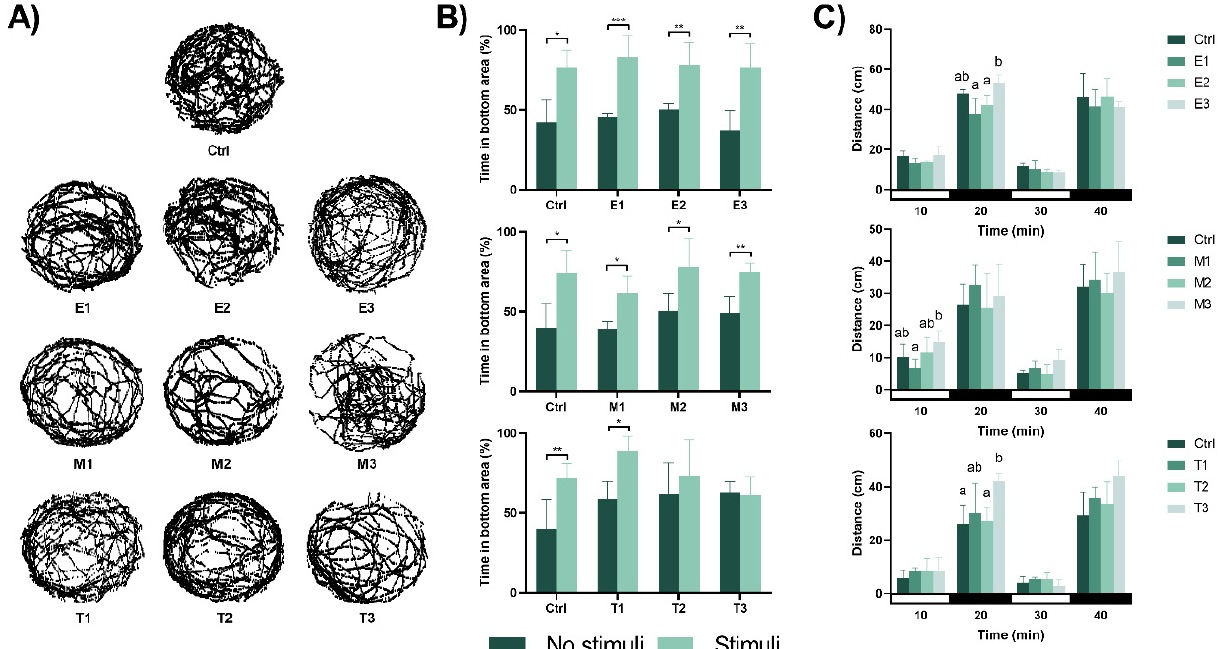
Figure 4. Effects of the different concentrations of the phyto-fungicide on zebrafish eleutheroembryo motor behaviour. ( A ) Representative swimming tracks of untreated and treated zebrafish eleutheroembryo at 120 hpf. No significant changes were observed between the different treatments and the control group during the 10 min recording period. ( B ) Avoidance behaviour of the zebrafish eleutheroembryo in the presence of an aversive stimulus. Data is expressed as mean ± SD from five independent replicates (5 eleutheroembryo assayed for each treatment). Statistical analysis was performed using t-test: * p < 0.05, ** p < 0.01 and *** p < 0.001. ( C ) Distance moved during the visual motor response test. Data represent the mean distance moved during 10 min assay and is expressed as mean ± SD from five independent replicates (5 eleutheroembryo assayed for each treatment). Statistical analysis was performed using one-way ANOVA followed by Tukey’s multiple-comparison test. Different lowercase letters indicate significant differences between groups ( p < 0.05).